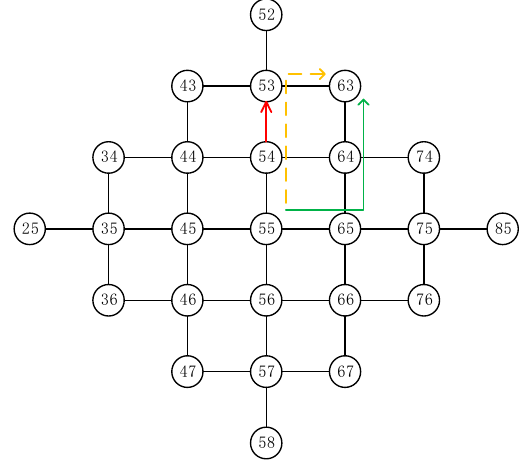
Figure 4. Early detour strategy for failed links.